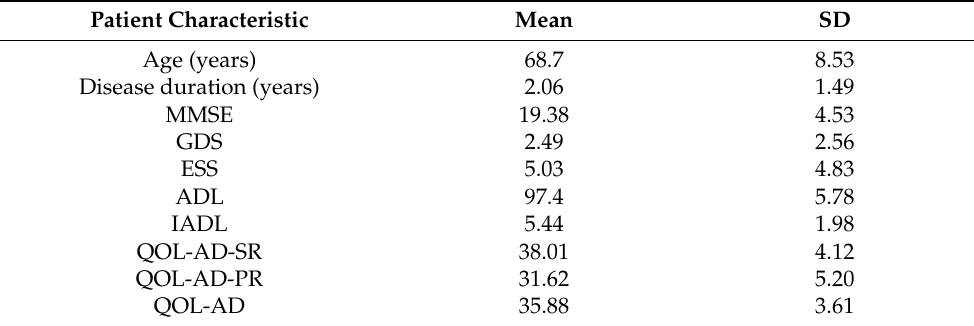
Table 1. Sociodemographic and clinical characteristic of participants. Patient